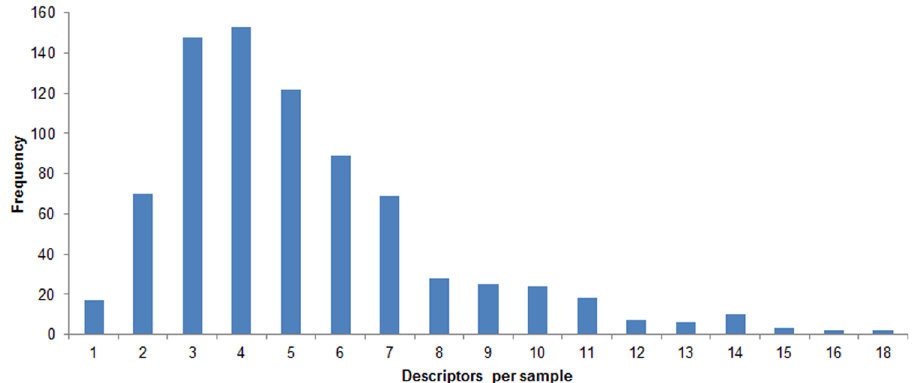
Fig 1. Frequency distribution of number of descriptors applied to each sample by each participant. Maximum number of descriptors for a given sample was 48. The total number of sample evaluations displayed is 793.